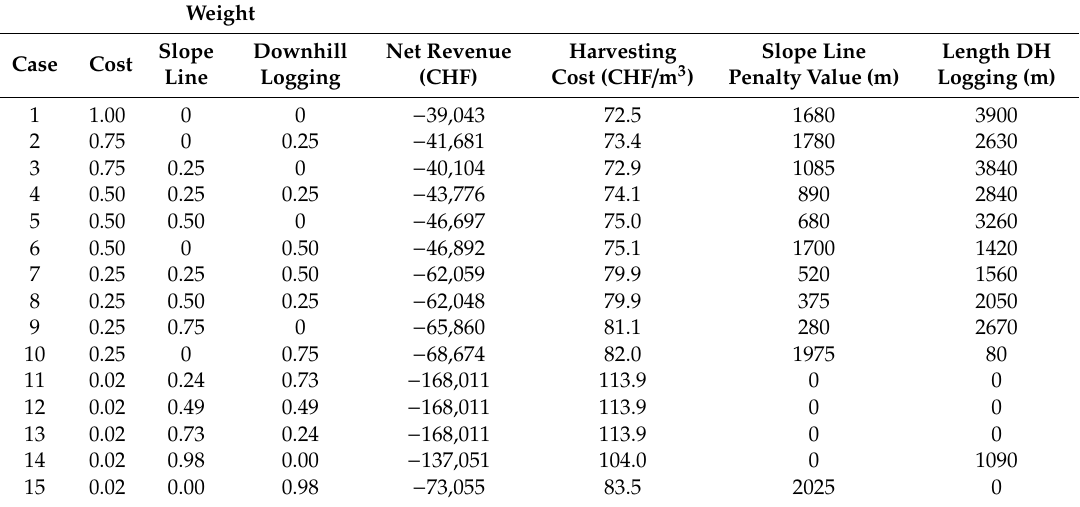
Table 5. Key values for di ff erent objective weighting alternatives (Rigi, Sub-area 1).